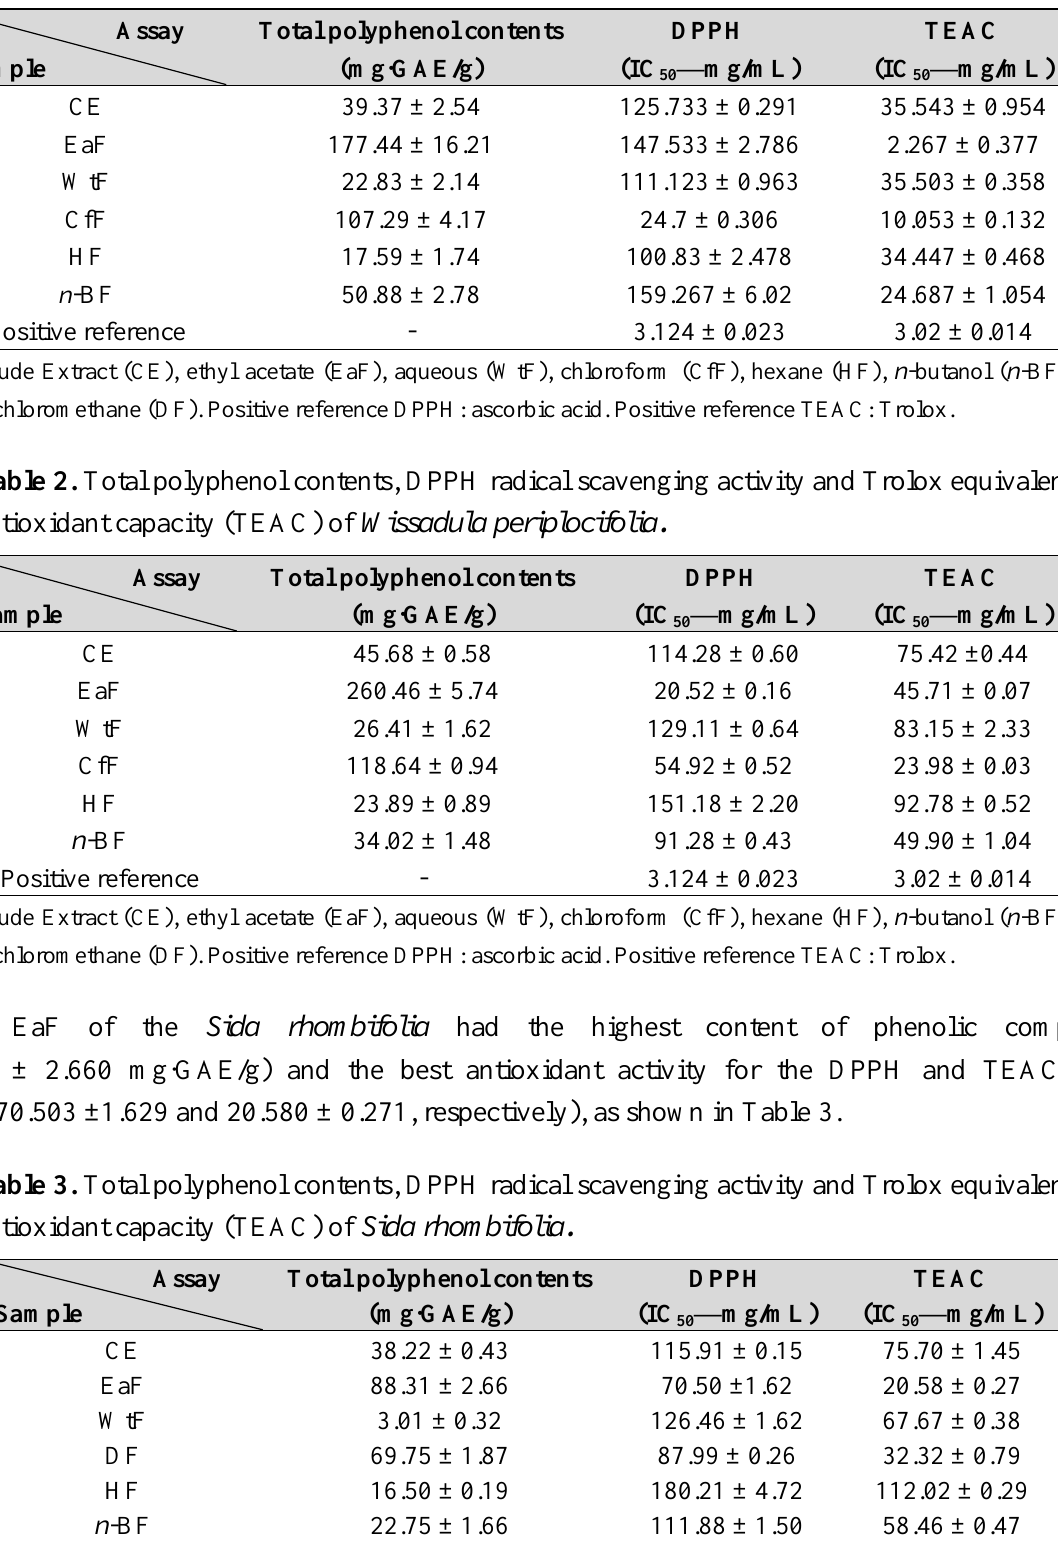
Table 1. Total polyphenol contents, DPPH radical scavenging activity and Trolox equivalent antioxidant capacity (TEAC) of Sidastrum micranthum.